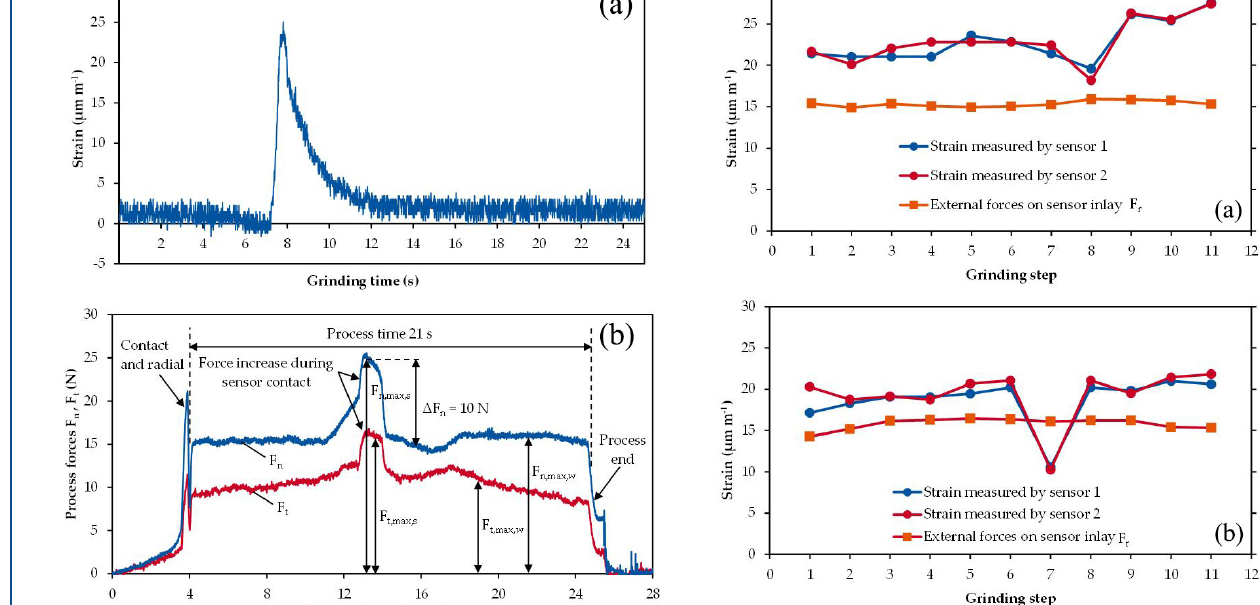
Figure 11. (a) Strain curve as measured by one of the sensors at the second grinding step over time. (b) Process forces in the normal ( F n ) and tangential ( F t ) directions obtained at the second grinding step over the time period of the grinding step.